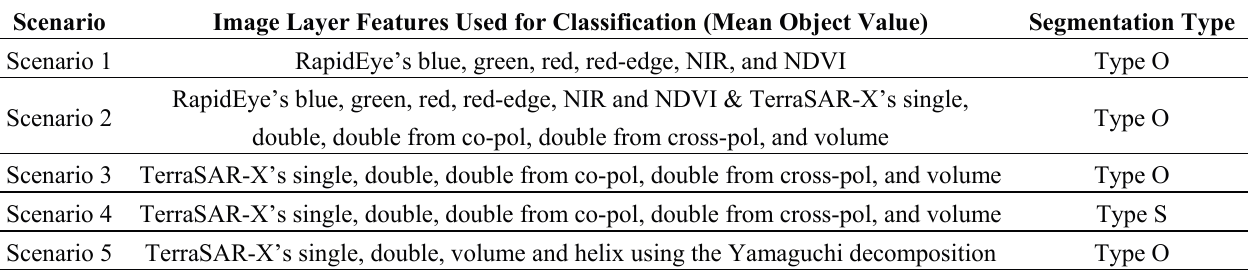
Table 3. Classification